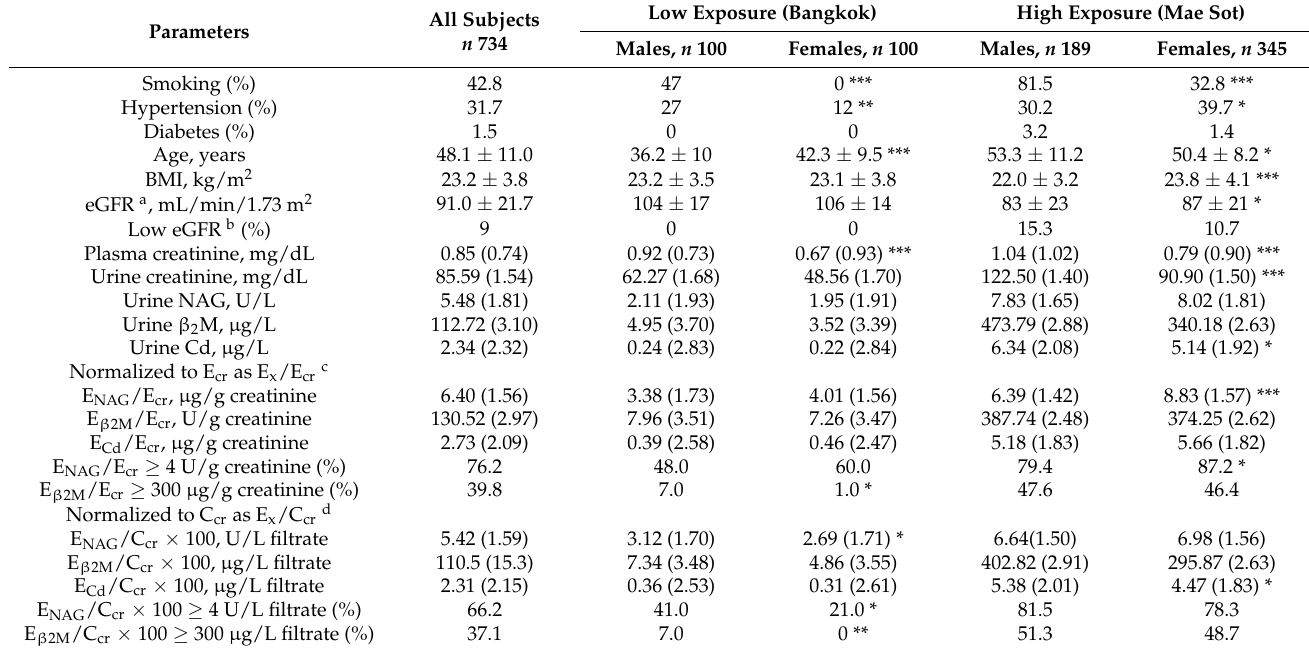
Table 1. Characteristics of the study subjects, stratified by residential location and